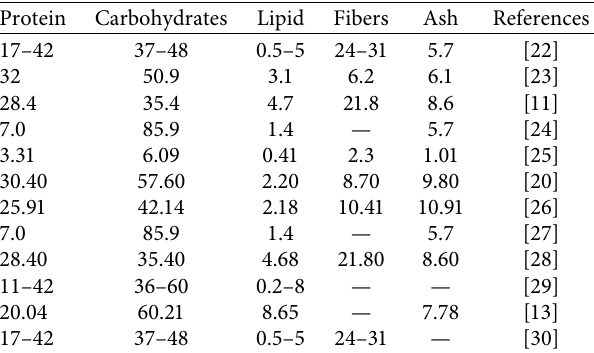
basis (%). Protein Carbohydrates Lipid Fibers